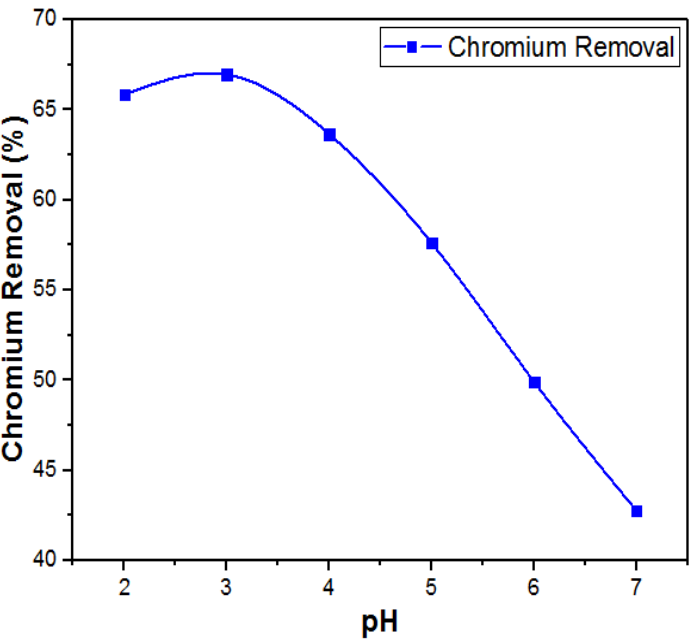
Figure 14. Effects of pH on removal of Cr (VI).